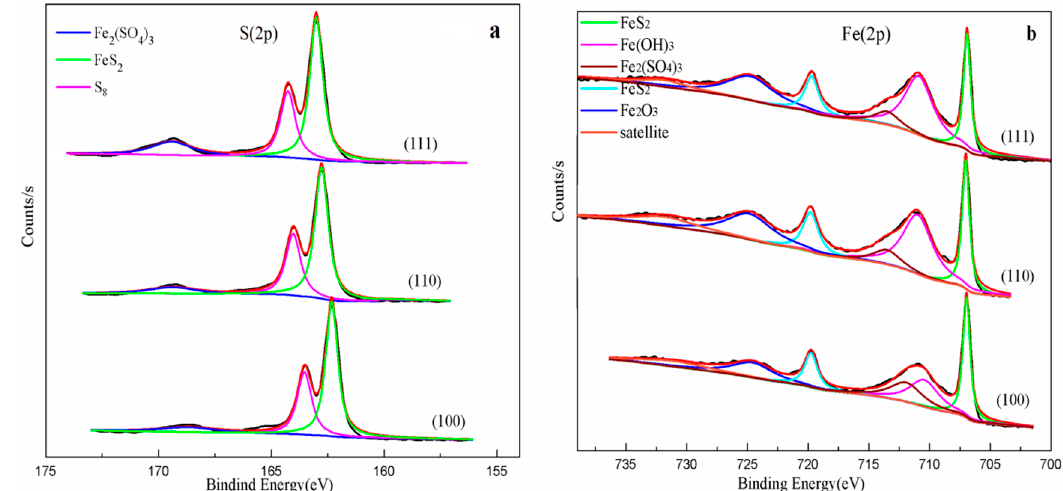
Figure 7. XPS spectra of pyrite (100), (110), and (111): S(2p) ( a ), and Fe(2p) ( b ).